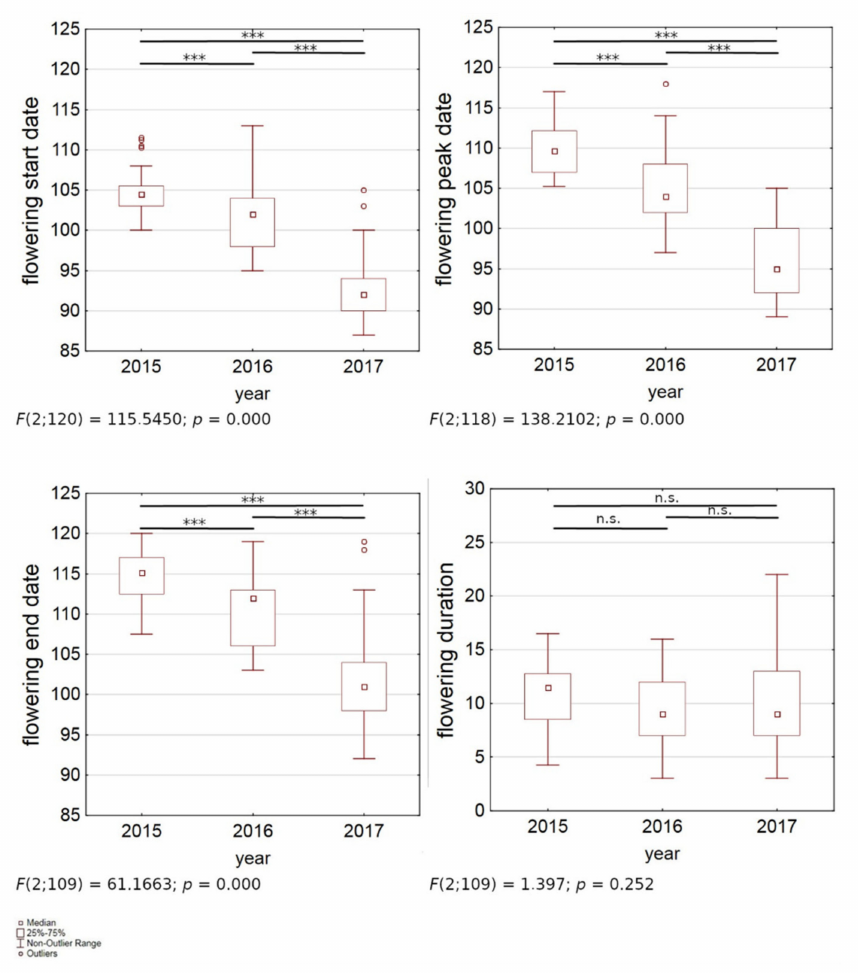
Figure 5. Differences between years in Betula pendula flowering season ( Y axis: start, peak, end dates, and duration) in Augsburg during 2015–2017 ( X axis) (ANOVA, ns: not significant relationship, ***: p <